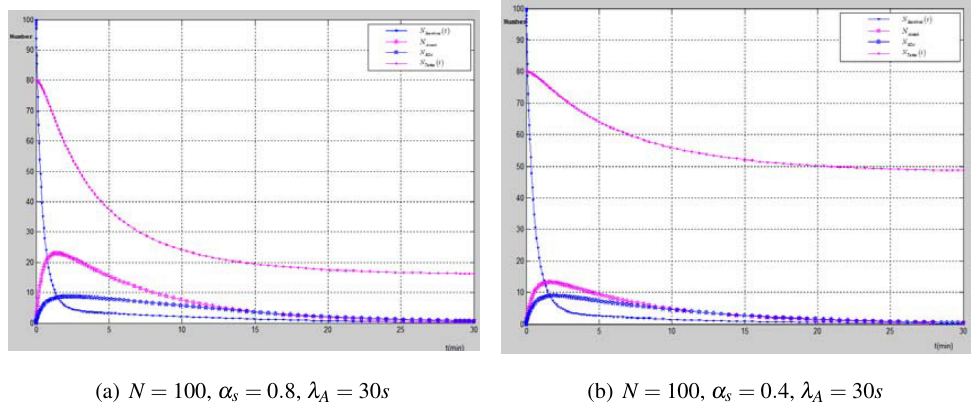
Fig. 2 The number of task state with respect to time at different probability of detecting the target value.